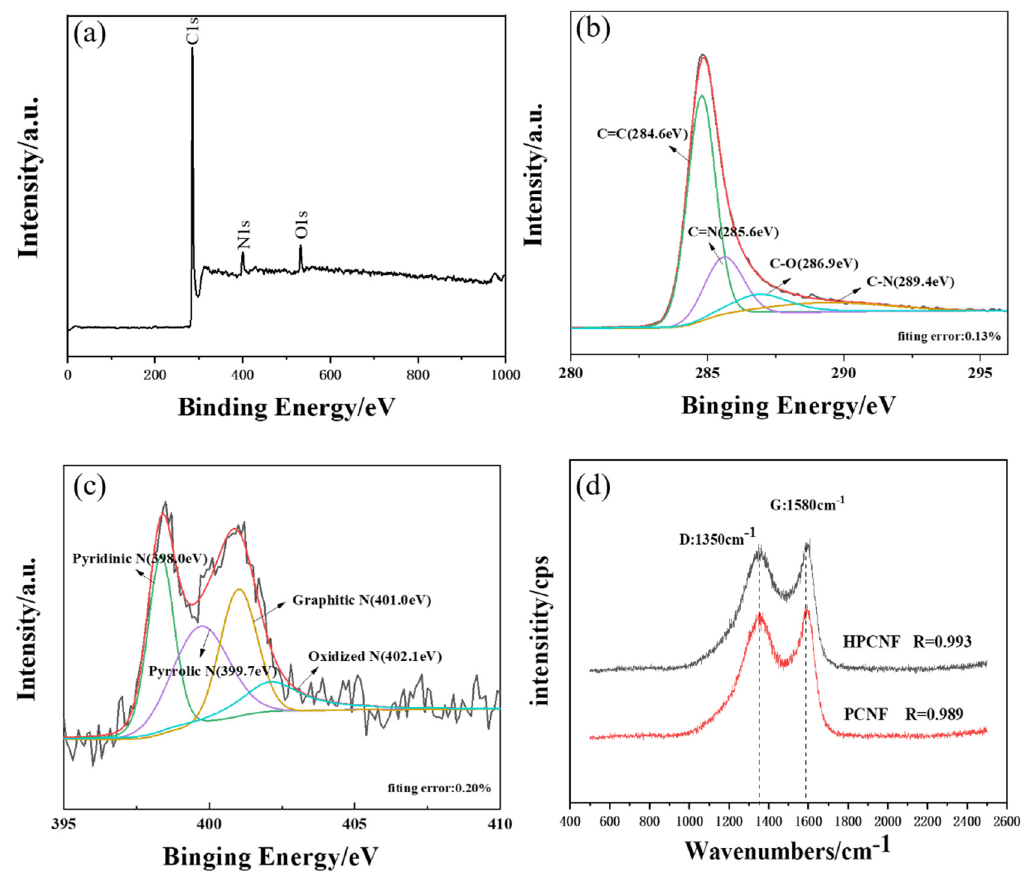
Figure 2. ( a ) XPS spectrum of HPCNF; ( b ) C 1s high − resolution XPS spectrum; ( c ) N 1s high − reso- lution XPS spectrum; ( d ) Raman spectroscopy of PCNF and HPCNF. high − resolution XPS spectrum; ( d ) Raman spectroscopy of PCNF and